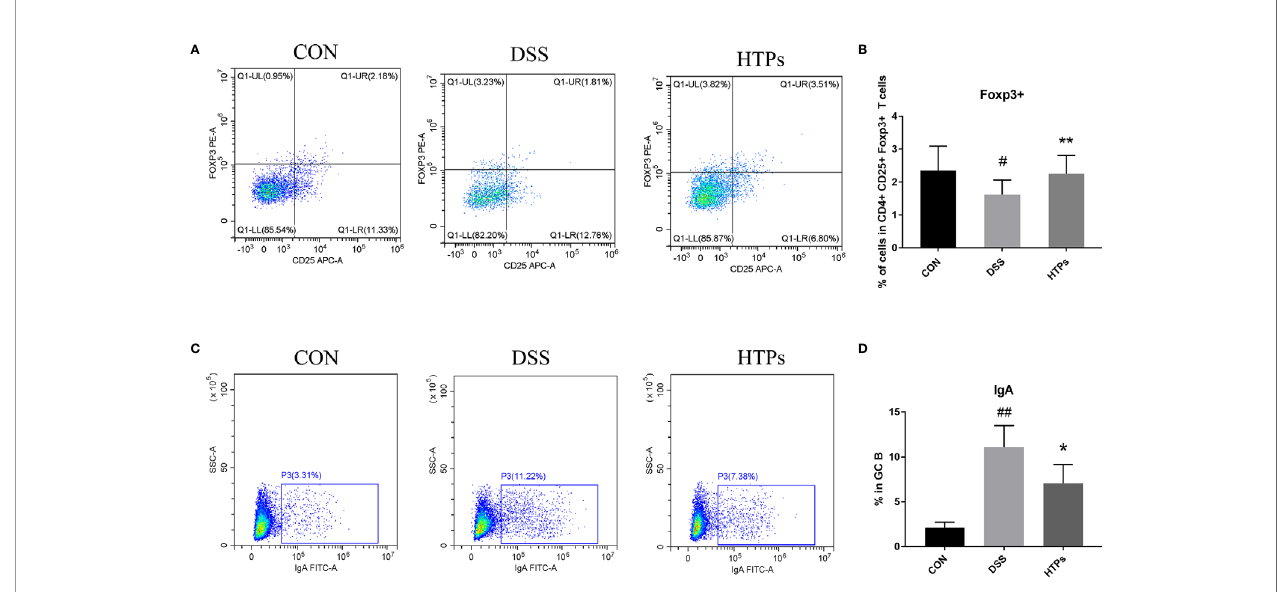
FIGURE 5 | Flow cytometry analysis of the populations of Treg (CD4+CD25+Foxp3+) and IgAs from C57BL/6 mice. Representative dot plots from mesenteric lymph nodes and intestinal contents. Treg (CD4+CD25+Foxp3+) and IgAs in (A, C) respectively. Relative expression of Treg (CD4+CD25+Foxp3+) and IgAs in (B, D) . CON, Control group; DSS, DSS challenge group; LTPs, DSS challenge + 200 mg/kg TPs; HTPs, DSS challenge +300 mg/kg TPs. All values are represented as mean ± SD ( n = 6). # p < 0.05, ## p < 0.01 v . normal group. * p < 0.05, ** p < 0.01 v . control group.